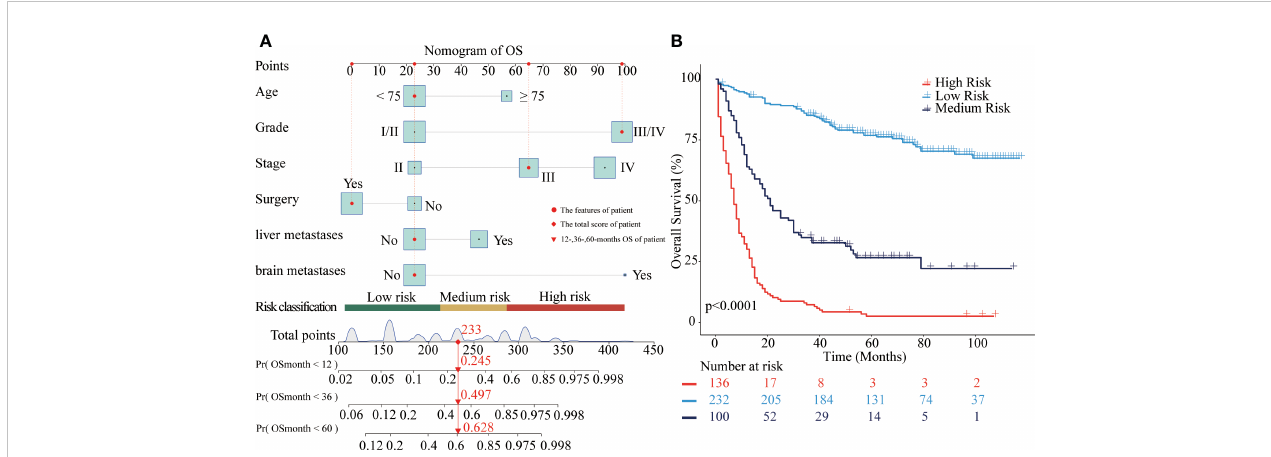
FIGURE 2 Nomograms to predict OS for patients with CRNENs and risk strati fi cation. (A) nomogram of OS. (B) the Kaplan-Meier curve of the high-risk, medium- risk, and low-risk groups. CRNENs, colorectal neuroendocrine neoplasms; OS, overall